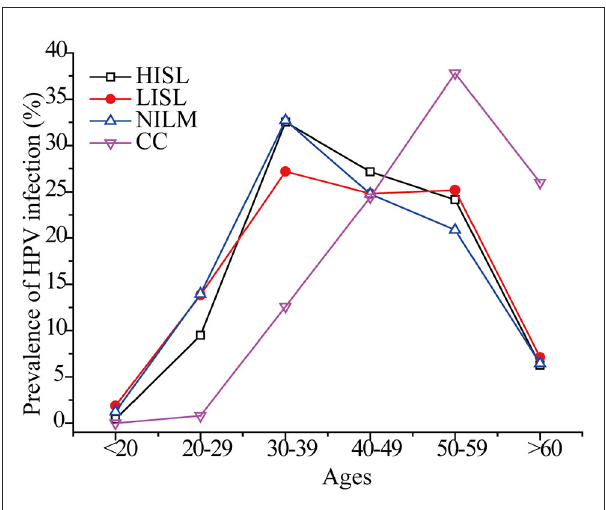
FIGURE6 Age distribution of HR-HPV prevalence in 3,943